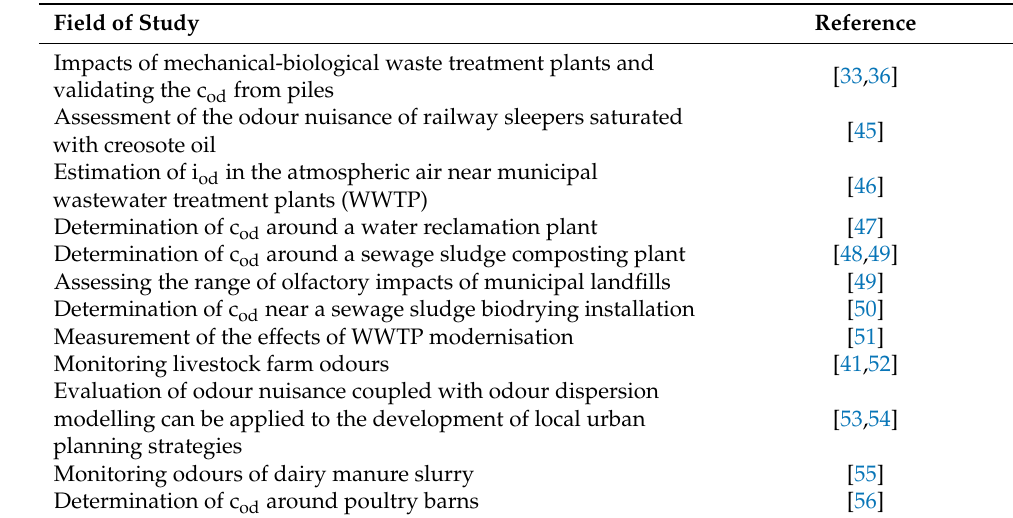
Table 1. Examples of the use of field olfactometers in various research areas. Field of